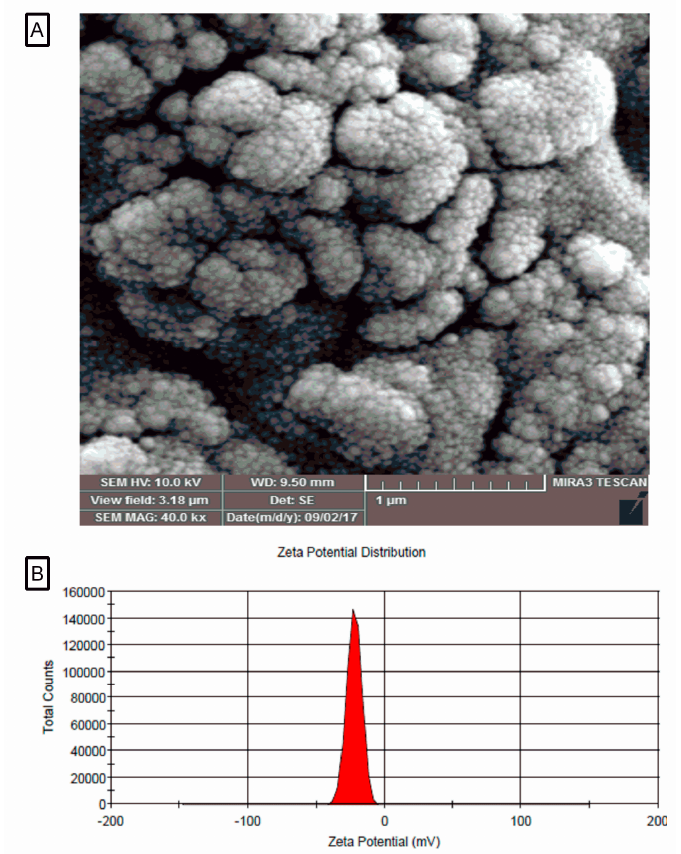
Figure 1. SEM photograph ( A ), zeta potential of the liposomal system containing juglone ( B ).